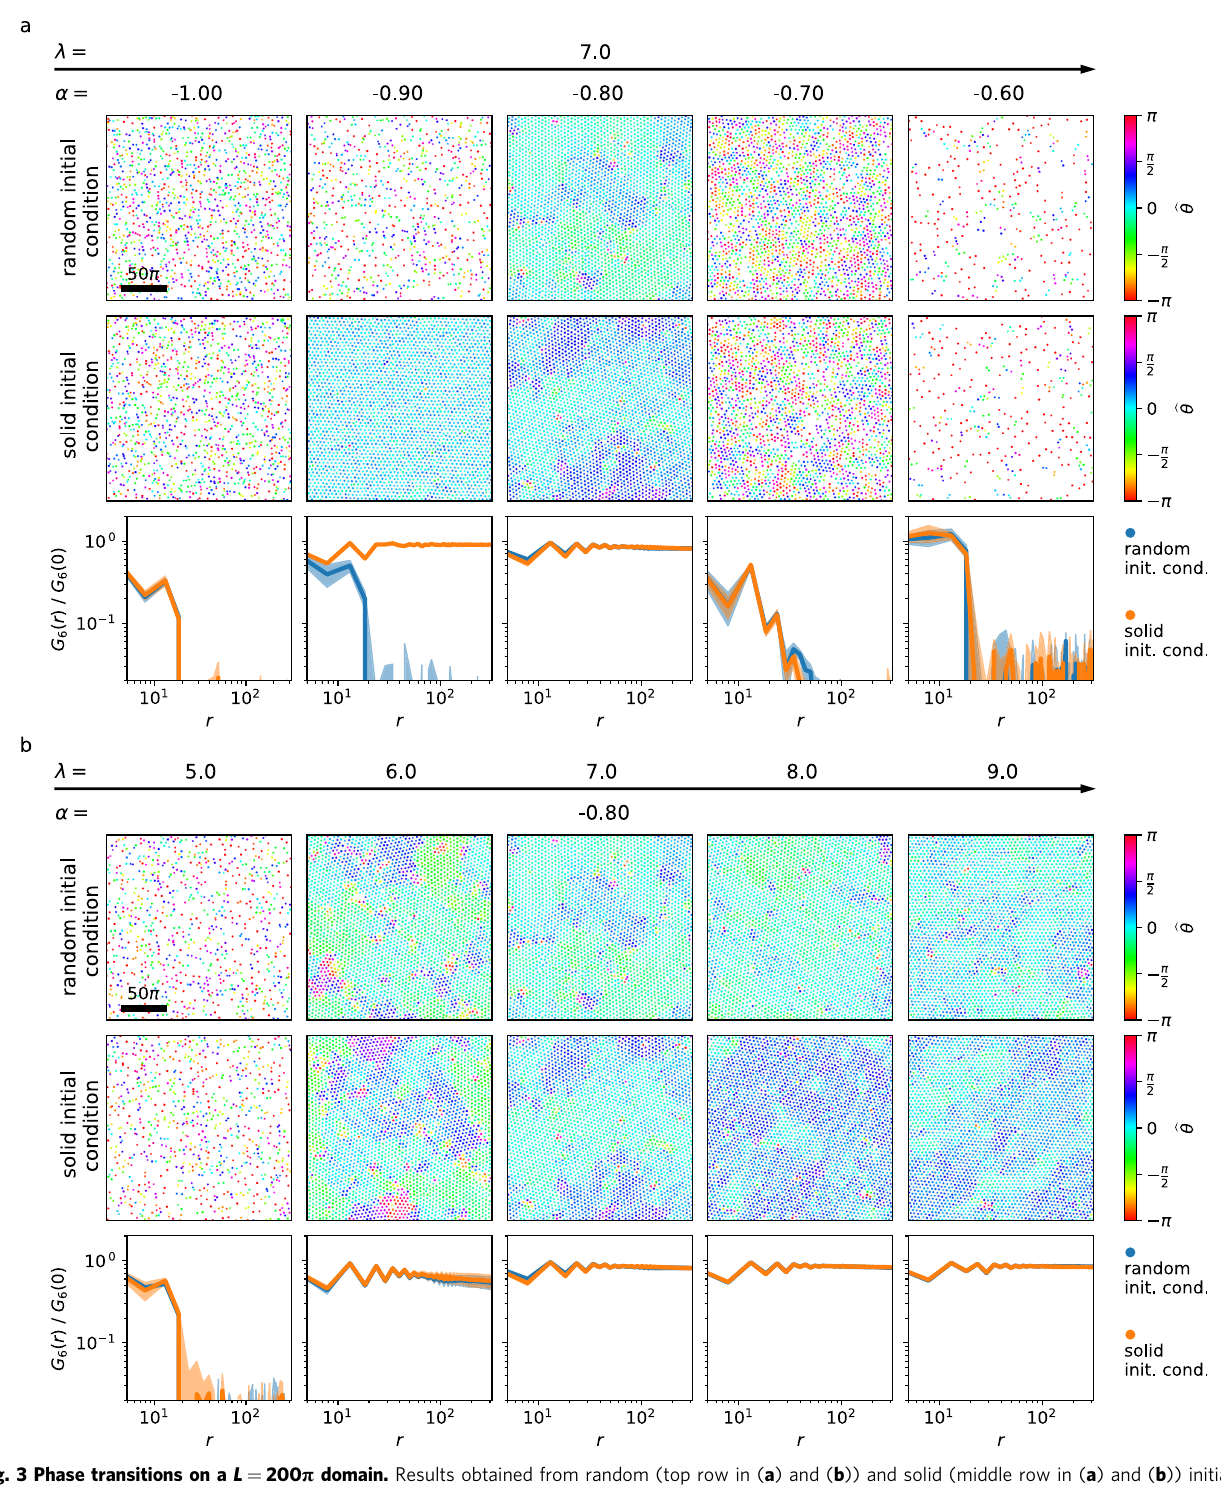
Fig. 3 Phase transitions on a L = 200 π domain. Results obtained from random (top row in ( a ) and ( b )) and solid (middle row in ( a ) and ( b )) initial conditions. ( a ) For λ = 7 and increasing α , the orientational correlation functions (bottom row) suggest a hysteretic transition from the liquid to the hexatic phase, followed by a non-hysteretic transition from the hexatic phase to the liquid phase. In the latter transition region, ordered vortex clusters coexist with an ambient liquid phase. ( b ) For increasing λ and α = − 0.8, we observe a transition from the liquid phase, over the hexatic phase, to the solid phase. The standard deviation of G 6 , calculated from three snapshots of the same simulation at different times, is plotted as an through parameter space ( λ = 7, α ∈ [ − 1.0, − 0.6], and the cut for fi xed λ . For α = − 1.0, we fi nd a liquid phase, irre- λ ∈ [5.0, 9.0], α = − 0.8) on L = 200 π domains. For each set of spective of the initial conditions. For α = − 0.9, we observe hys- parameters, we run two simulations, one with random initial teresis, i.e. either a liquid or a solid phase, depending on the initial conditions and one starting from the solid phase. Figure 3a shows condition. This matches the hysteresis region found on small